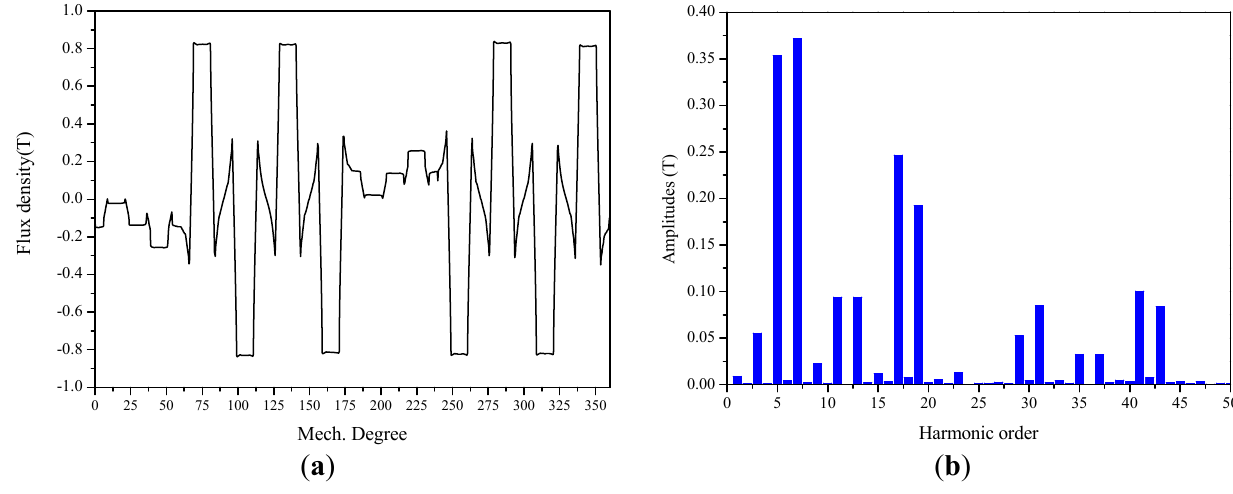
Figure 5. MMF harmonic analysis of the 24-slot asymmetric six-phase PMSMs having two adjacent coils per phase and equal teeth widths: ( a ) winding-produced air-gap flux density; and ( b )